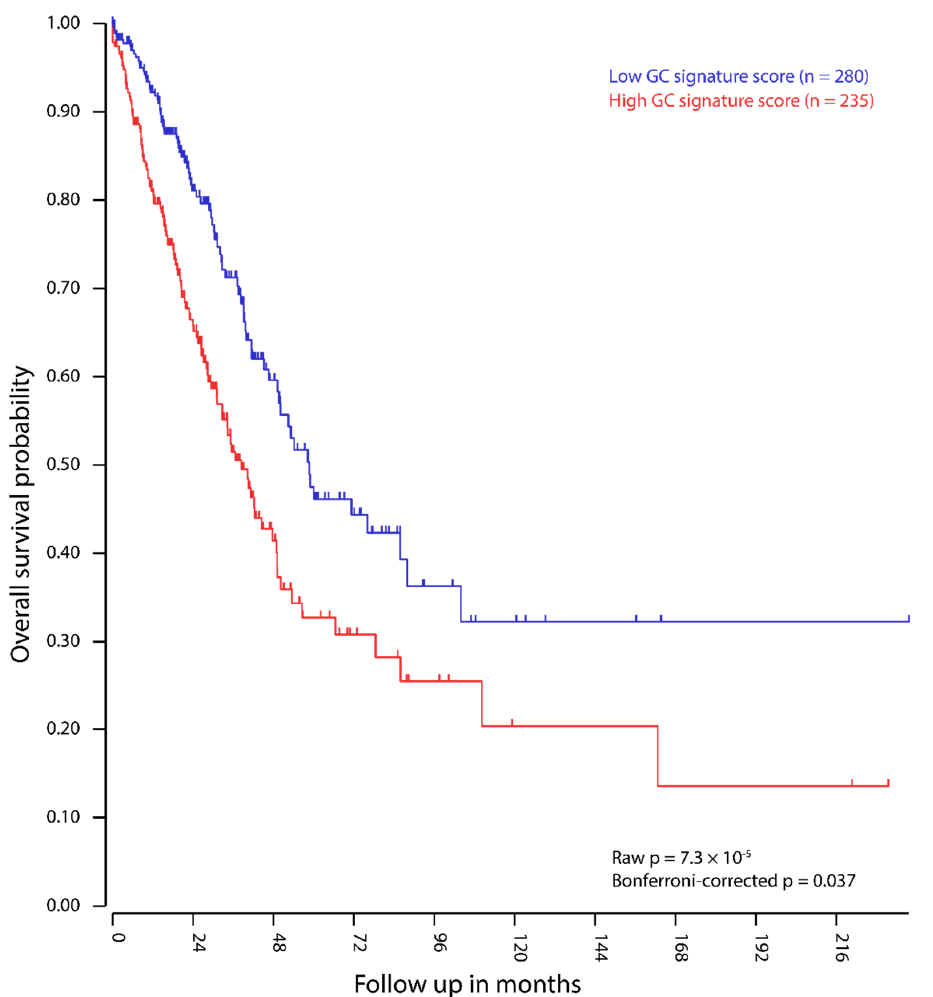
Figure 4. Kaplan–Meier curve of 515 lung adenocarcinoma patients, divided in two groups based on GC gene signature scores of their tumors. Figure derived from the bioinformatics platform R2’s Kaplan Meier Scanner.